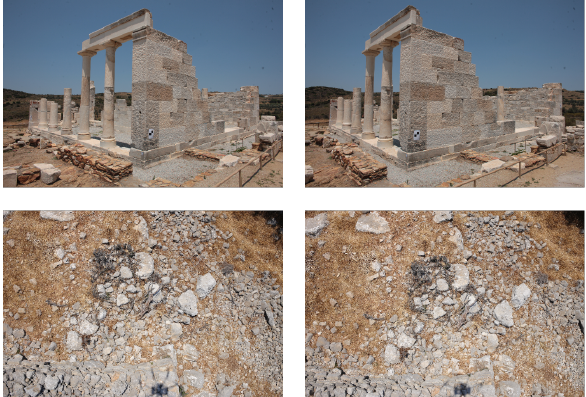
Figure 5. RGB images from Temple of Demeter (First row) and summer field course (Second